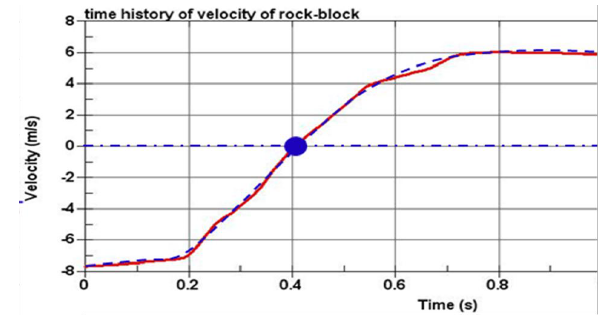
Figure 11. A typical time history response of the Y-velocity of the rock-block of Fig. (10). 2 Fig. 11. A typical time history response of the Global Y-velocity – The incident velocity was 17.33 m/s. 3 including initial coalesced motion – of the cylindrical block of 1 ton mass and the incident velocity of 17.33ms − 1 .